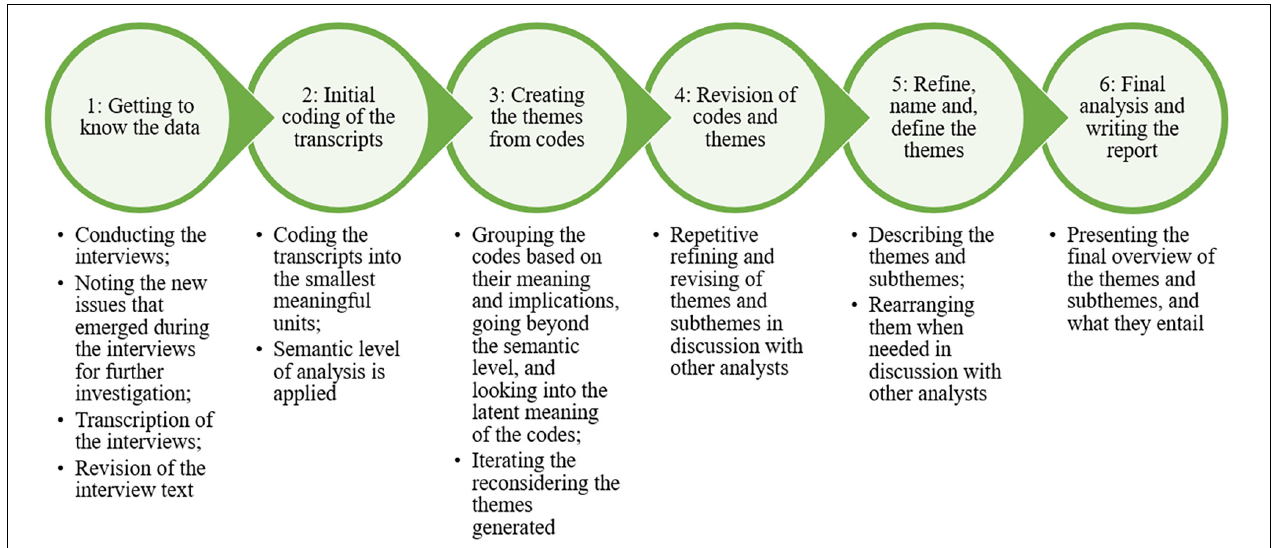
FIGURE 1 | Overview of the six phases of thematic